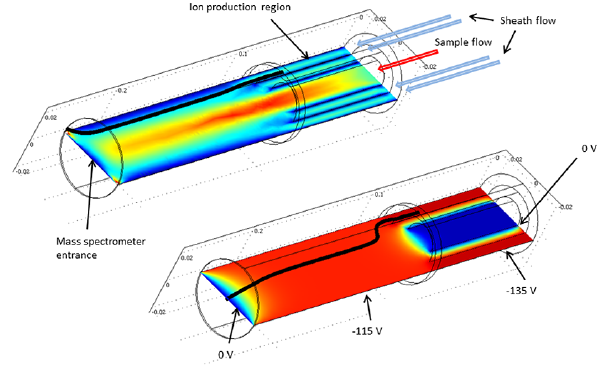
Figure 2. Dimethyl (DMA) and/or ethyl amine (EA) and diethyl amine (DEA) form stable clusters already with bisulfate “trimer”, whereas ammonia, methyl amine (MA) and trimethyl/propyl amine (TMA/PA) are detected with “tetramer” or larger clusters.